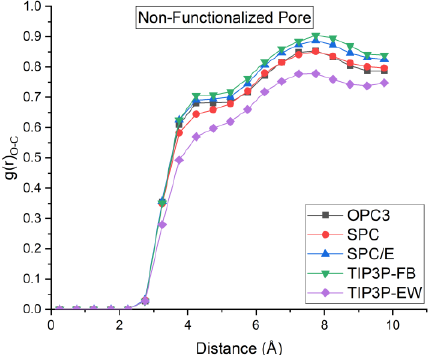
Figure 6. Radial distribution function of oxygen atoms of the water molecules with that of the carbon atoms inside the multilayered non-functionalized porous.